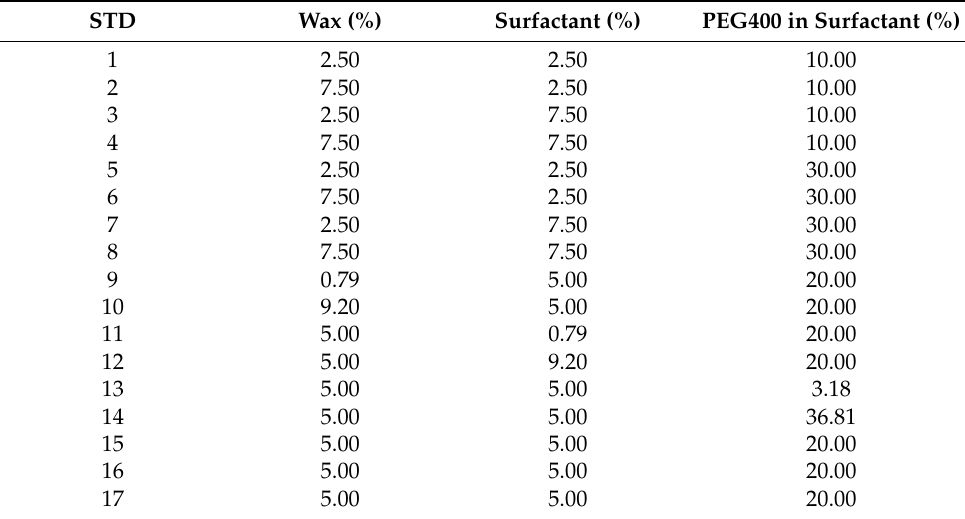
Table 1. The variable factors and their concentrations for the preparation of the